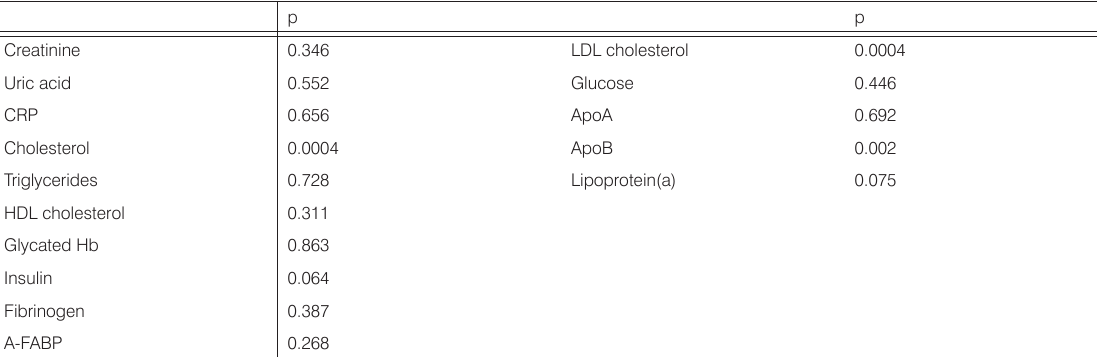
Table 3. Changes in laboratory parameters – comparison of males with newly administered statin therapy and males without statin therapy (Mann-Whitney